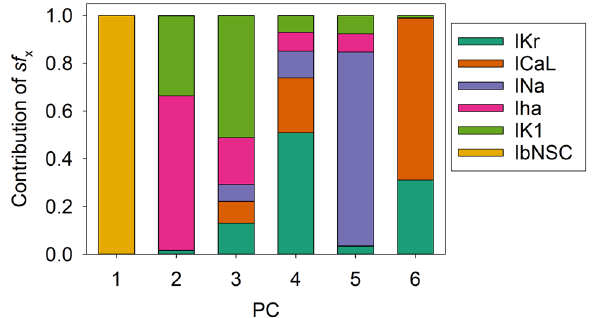
Figure 7. PC1 ~ 6 to describe distribution of the 6 sf x s. PC analysis was performed on the data population of the top 200 runs of the orp test as in Fig. 4, which showed good optimization results (Cell 86). Each magnitude of 6 PCs was normalized to give a unit magnitude. Note each PC is composed of multiple components of ionic current, which are indicated in the Index with corresponding